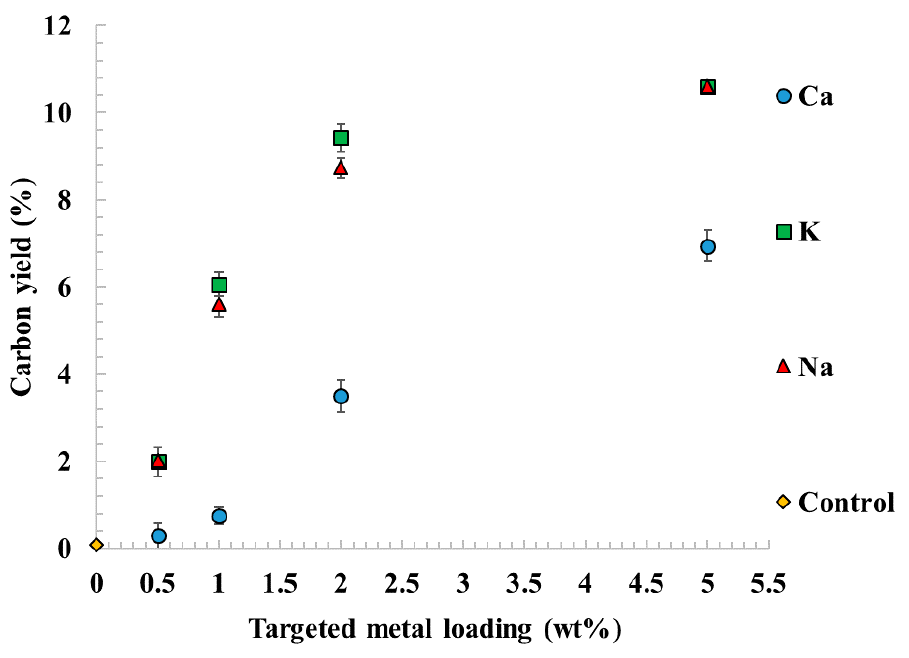
Figure 5. Oxygenated compounds yield from in-situ CFP experiments with H + ZSM-5 catalysts deactivated by inorganics.